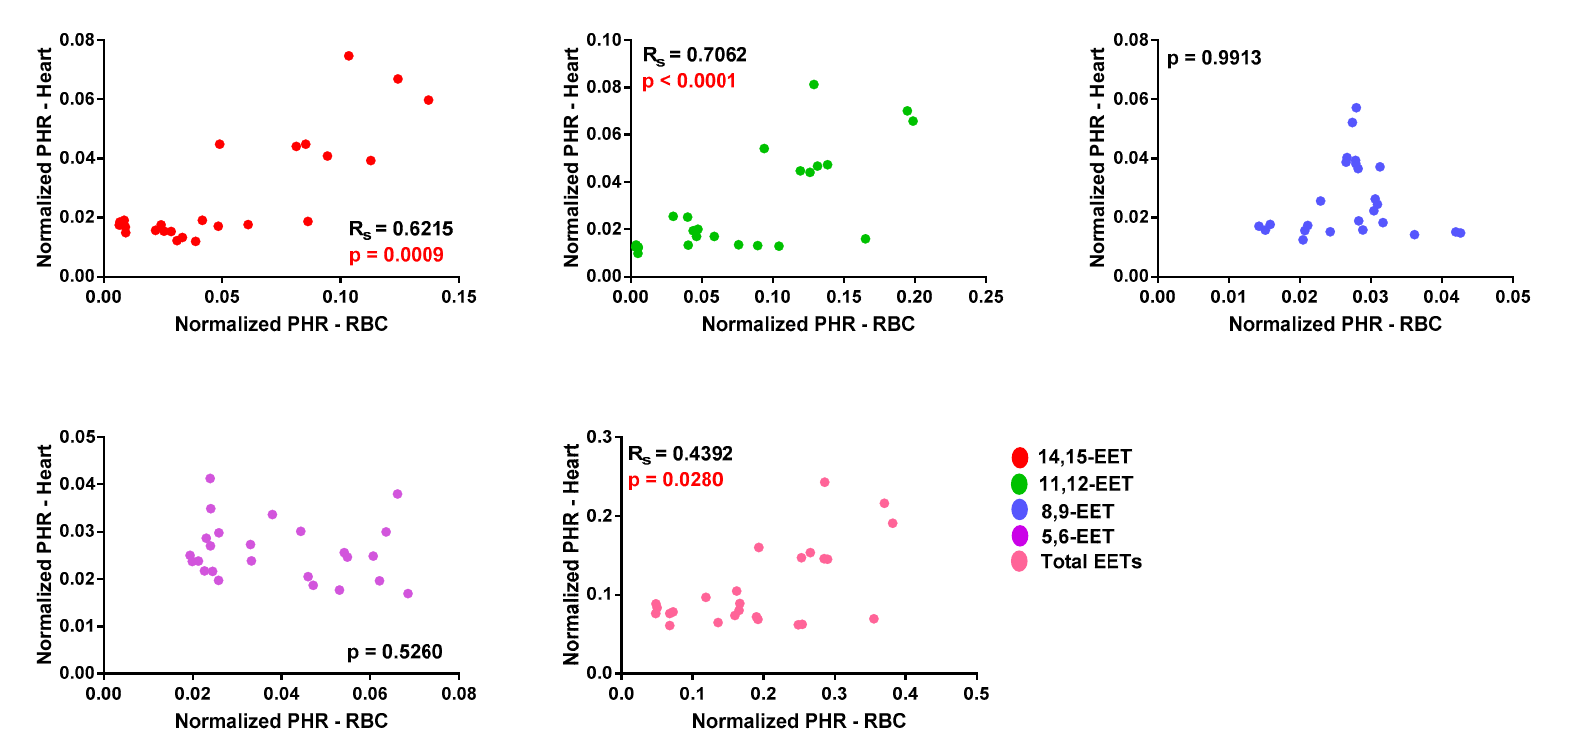
Figure 3. Correlation of each regioisomer of cis- epoxyeicosatrienoic acid (EET) and total cis- EETs in erythrocyte membrane and cardiac tissue of CYP2J2 transgenic mice. Relative amount of each EET regioisomer was represented by normalized peak height ratio peak height ratio (PHR) in erythrocyte membrane and cardiac tissue.